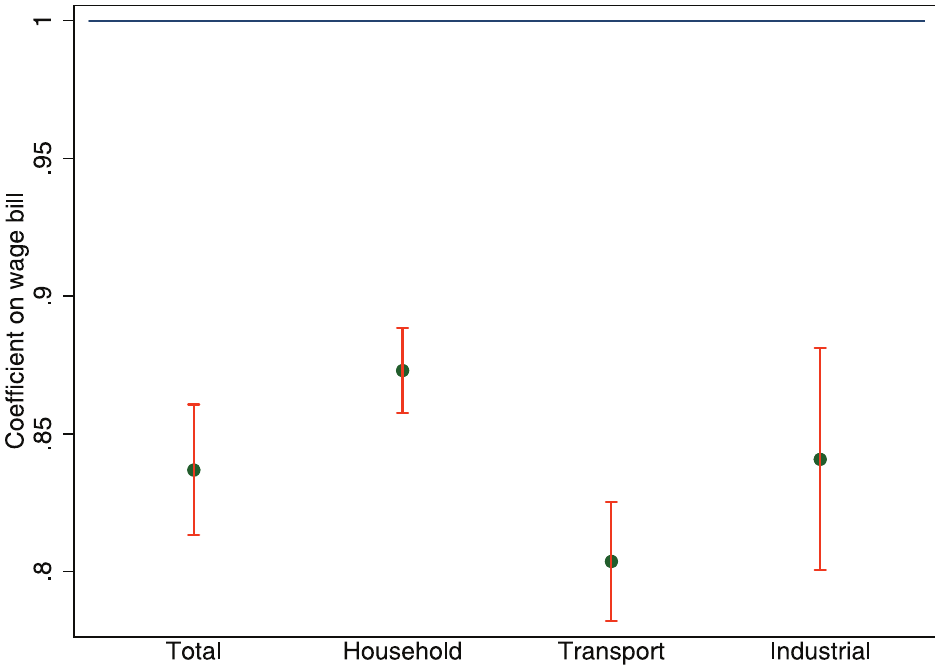
Fig 3. Urban energy premium by source of energy demand. The scaling of total energy demanded with respect to the total wage bill by source of energy demand. Each dot represents the estimated scaling coefficient for UK travel to work areas. The scaling coefficients were estimated by OLS and the 95% confidence intervals are shown as red